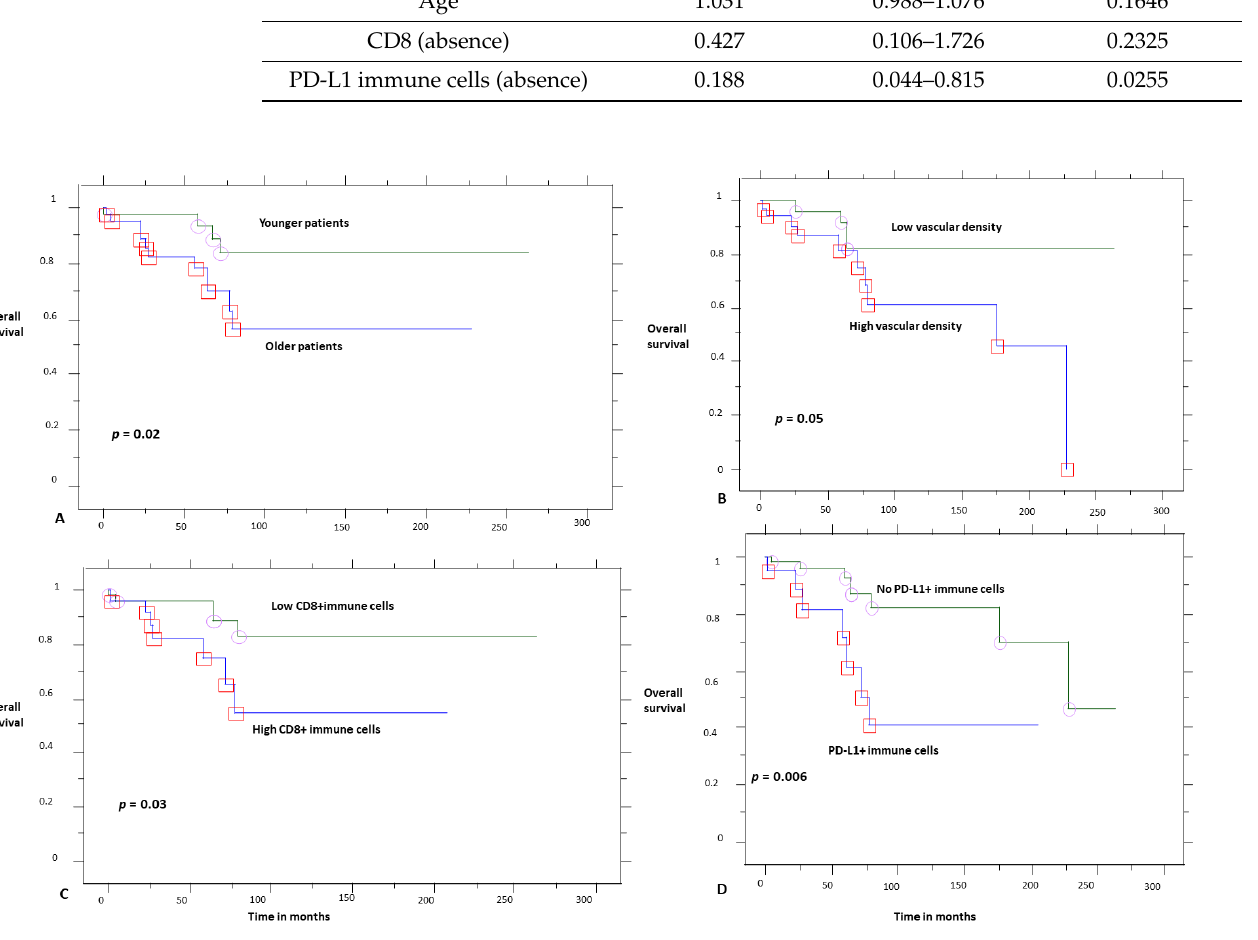
Figure 17. Overall survival according to age ( A ), vascular density ( B ), CD8 ( C ), and PD-L1 expression by immune cells ( D ). Circles and red squares correpsond to event times.